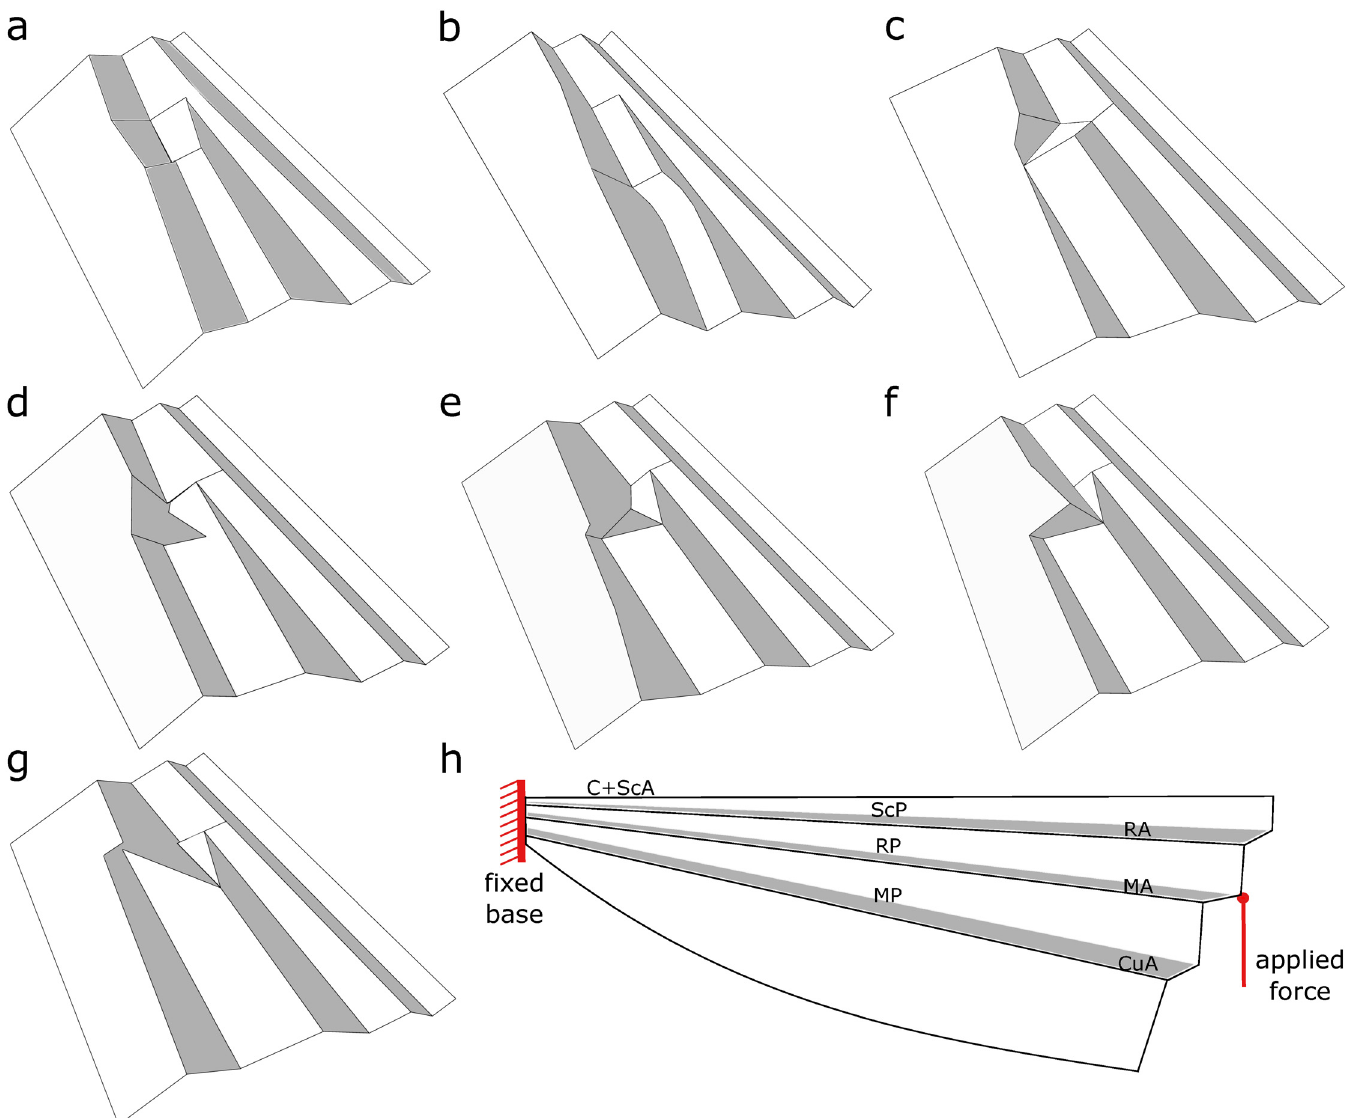
Fig 2. 3D configuration of the basal complex in the FE models of wings. The models were inspired by (a) Coenagrionid wings, (b) Chlorocyphid wings, (c) Heterophlebia forewing, (d) Heterophlebia hindwing, (e) Aeshnid forewing, (f) Libellulid forewing, (g) Libellulid hindwing (see Wootton and Newman, 2008). (h) Schematic view of a model under ventral loading. The external force is applied to RP, and the model is fixed at the wing